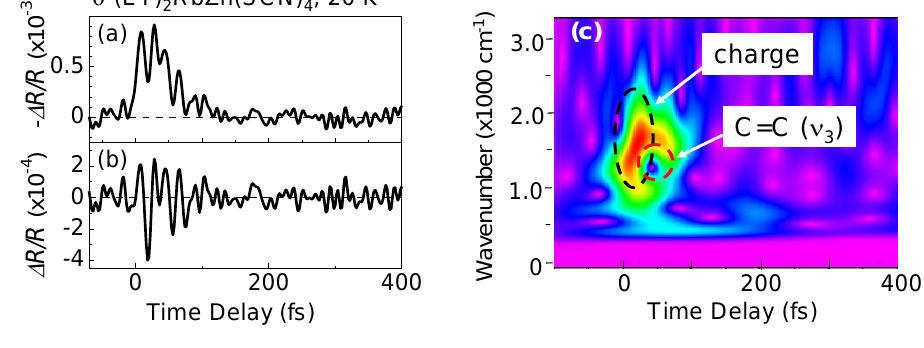
Figure 17. ( a ) Time evolution of  R / R in  -(ET) of  R / R and ( c )